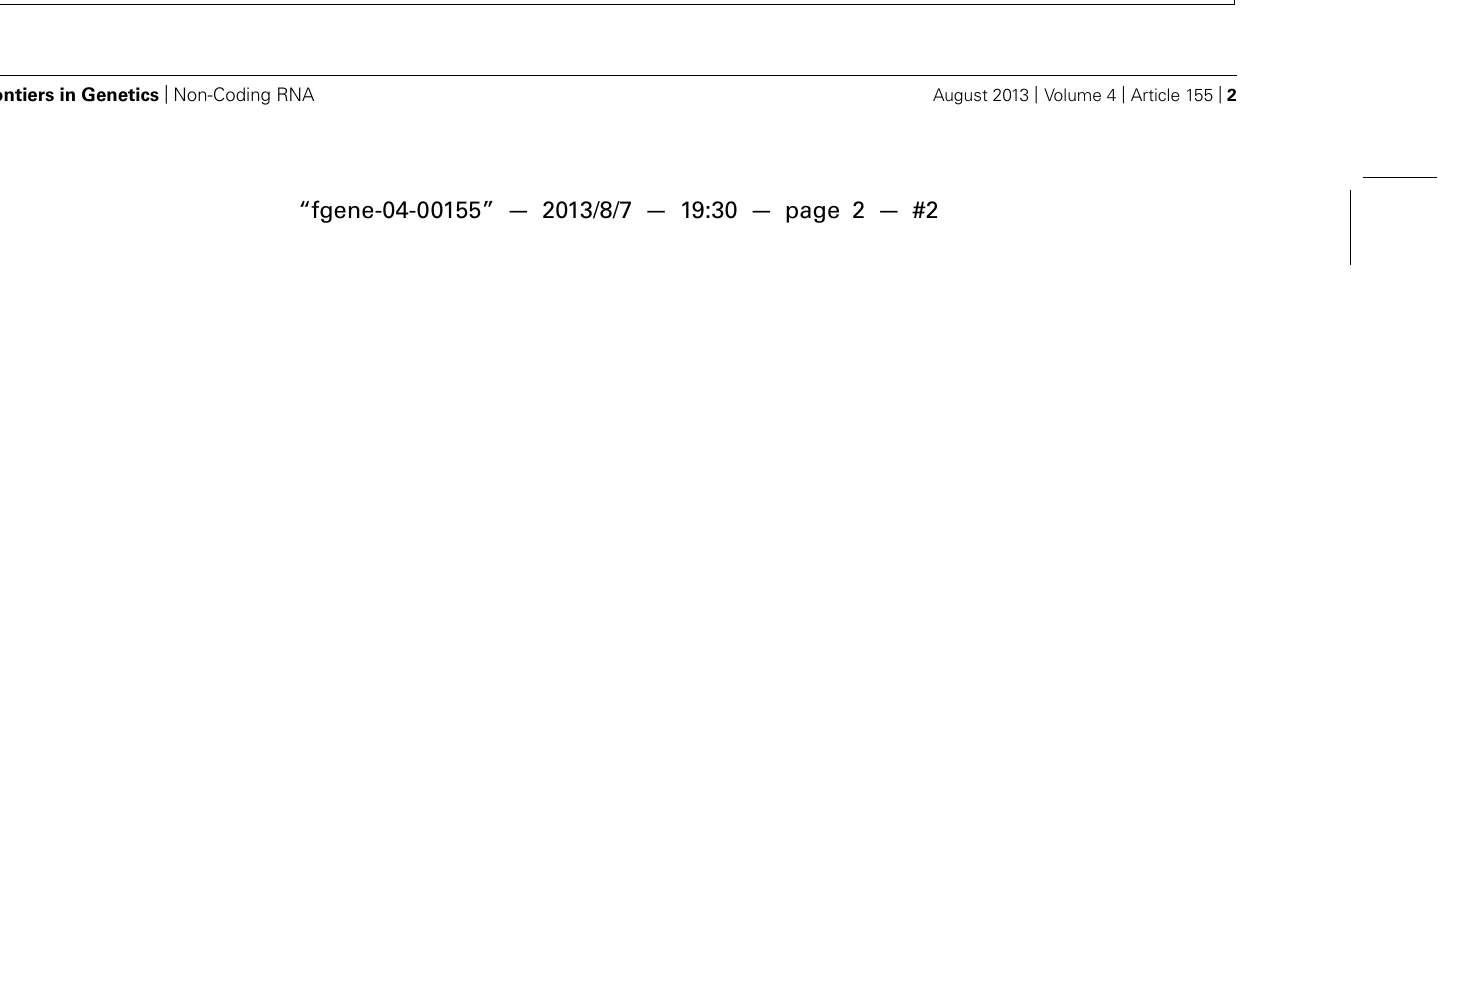
Frontiers in Genetics | Non-Coding